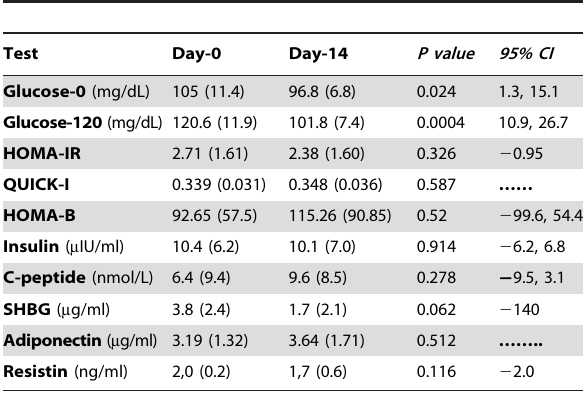
Table 4. Effects of Pioglitazone on glucose homeostasis, insulin resistance and secretion.